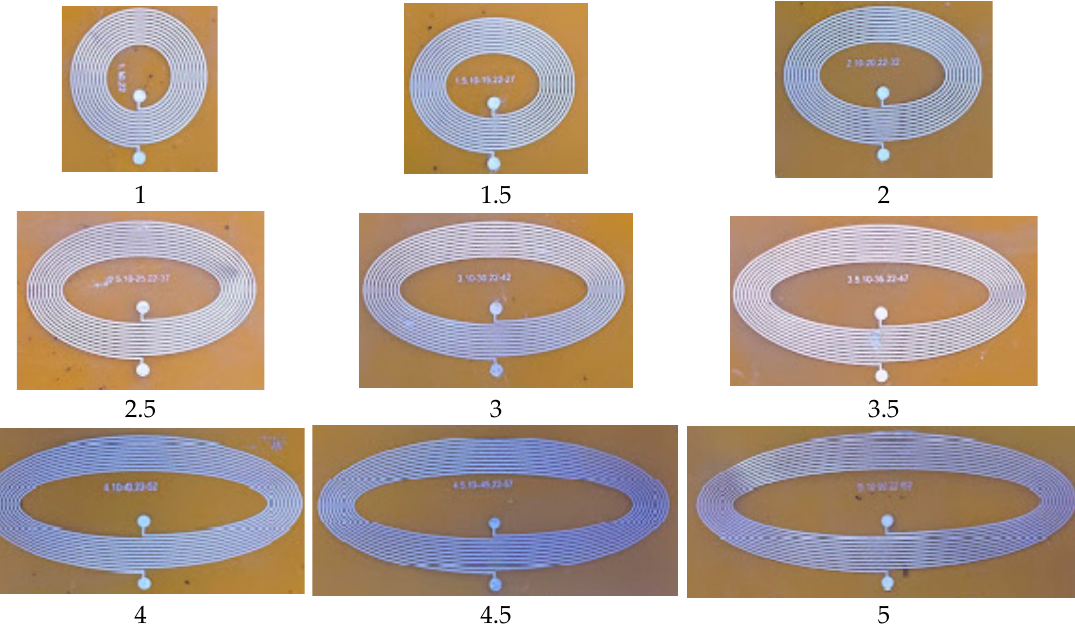
Figure 11. Fabricated elliptical planar inductors with varying major-to-minor ratio ( R ) values of between one and five with an interval of 0.5, while trace separation ( S ) = trace width ( W ) = 200 μ m. Table 8. Key results of elliptical planar inductors for varying ratios when trace separation ( S ) and trace width ( W ) were kept constant at 200 μ m.